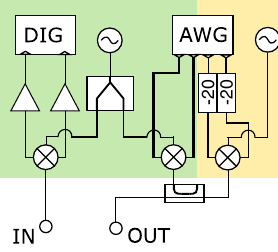
FIG. 9. Room-temperature setup for the measurements in Appendix C. DIG is for digitizer. Circuit symbols are defined in Fig. 6.